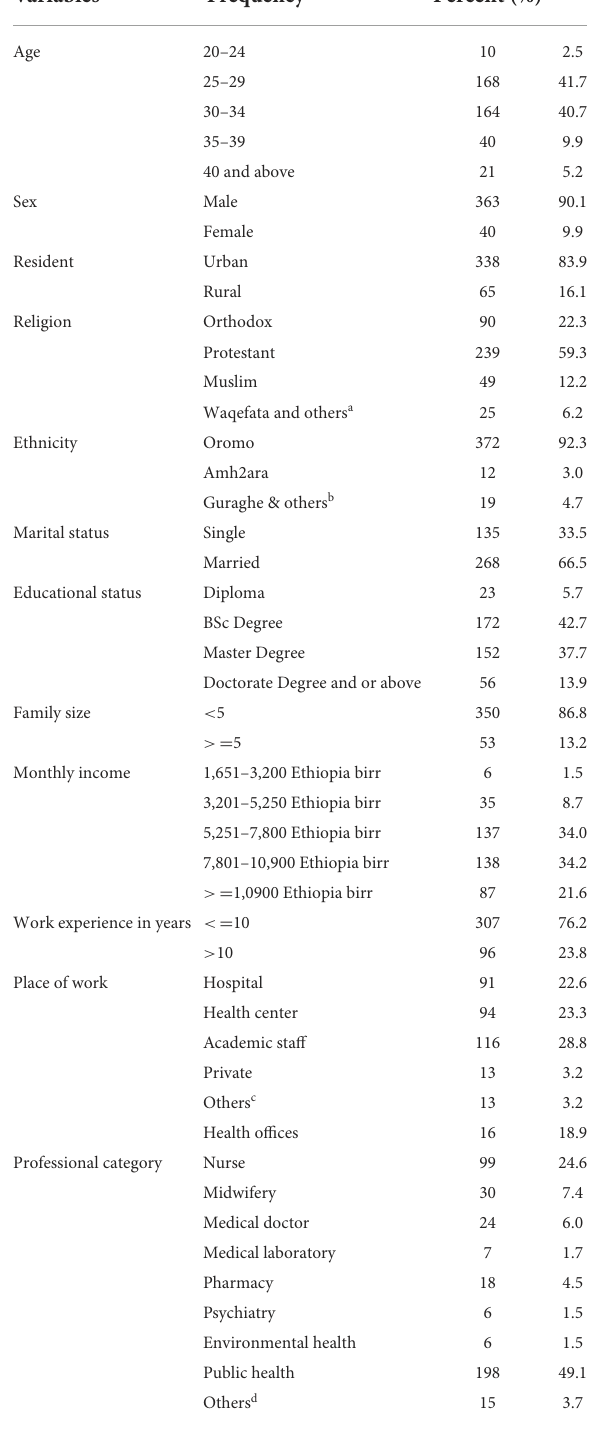
TABLE 1 Social-demographic Distribution of the Respondents ( N =